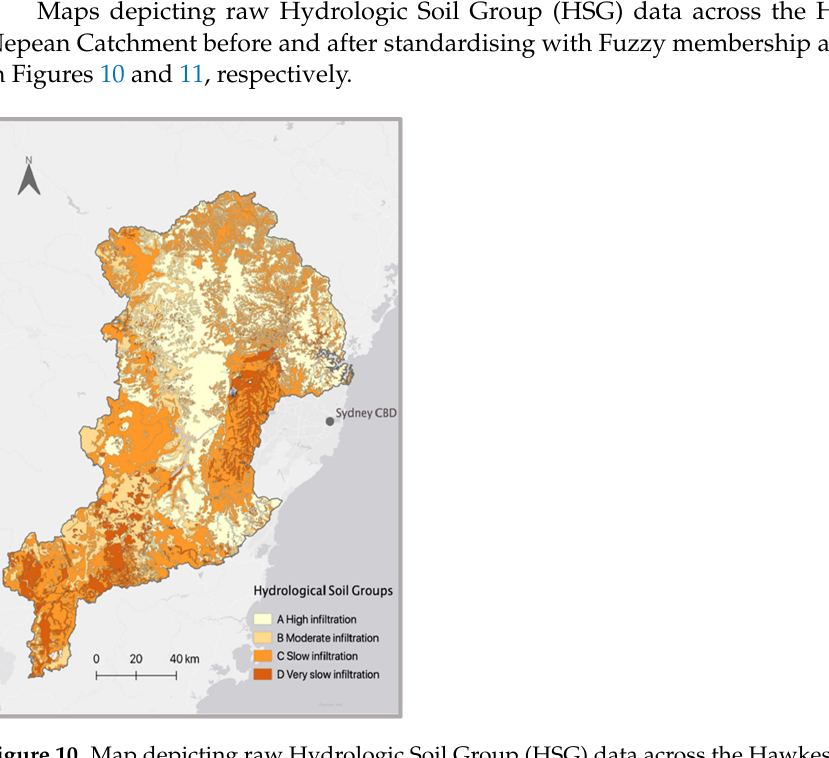
Figure 10. Map depicting raw Hydrologic Soil Group (HSG) data across the Hawkesbury-Nepean Catchment before standardising with Fuzzy membership.